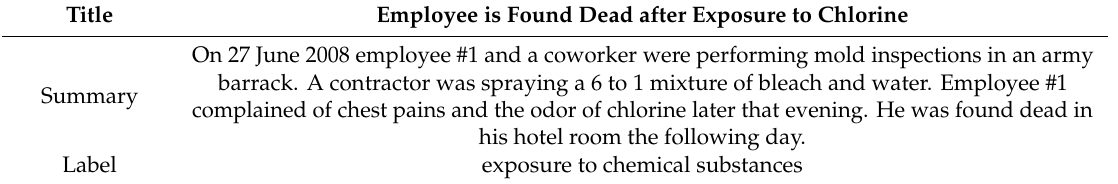
Table 1. Example of accident narrative (with label).